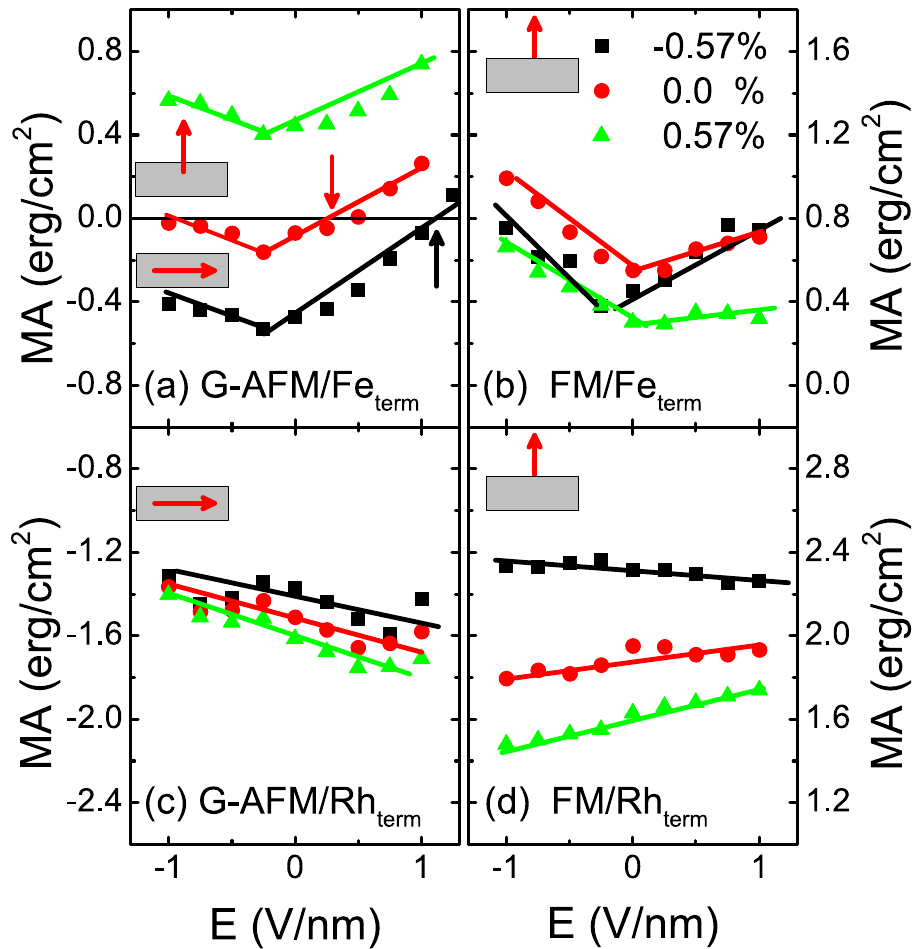
Figure 3. MA versus E-field in MgO for the Fe-terminated surface/interface film in the ( a ) G-AFM and ( b ) FM phases; and for the Rh-terminated surface/interface in the ( c ) G-AFM and ( d ) FM phases for different strain values. Note the different scale in left- and right-hand